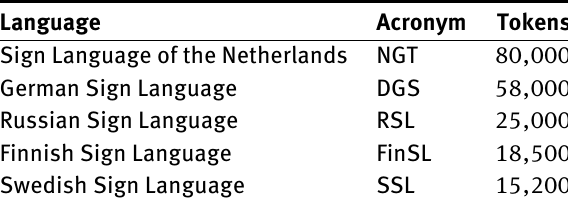
Table 1: The corpus datasets for each of the five sampled sign languages in this study by number of